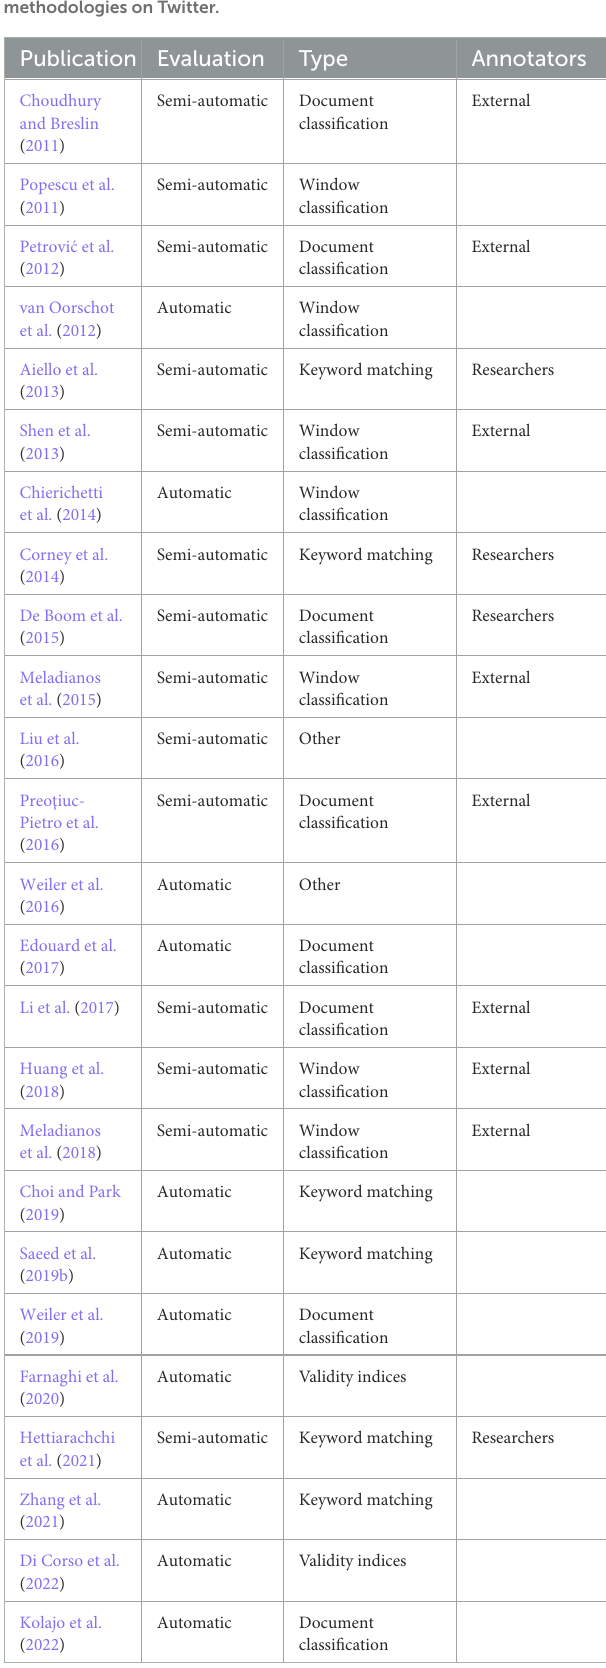
TABLE 2 A summary of semi-automatic and automatic TDT evaluation methodologies on